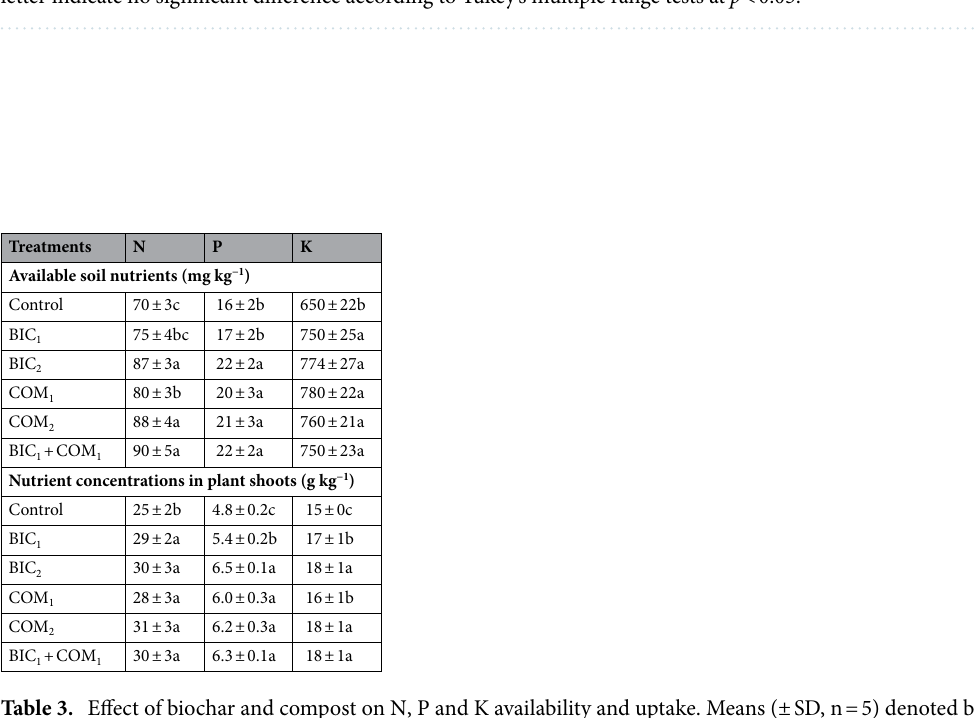
Figure 2. Effect of biochar and compost on enzymatic activity of dehydrogenase and phosphatase. BIC 1 and BIC 2 = biochar at rates of 1 and 2% (w/w), COM 1 and COM 2 = compost at rates of 1 and 2% (w/w), and BIC 1 + COM 1 = mixture of the two amendments at 1% (w/w) of each. Means (± SD, n = 5) denoted by the same letter indicate no significant difference according to Tukey’s multiple range tests at p < 0.05.